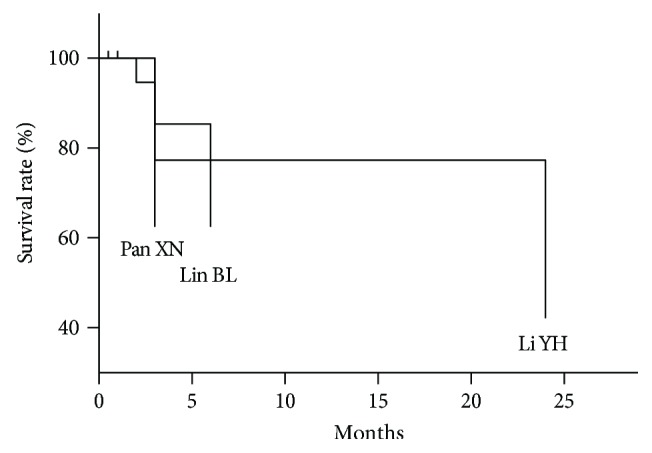
The survival of LF.